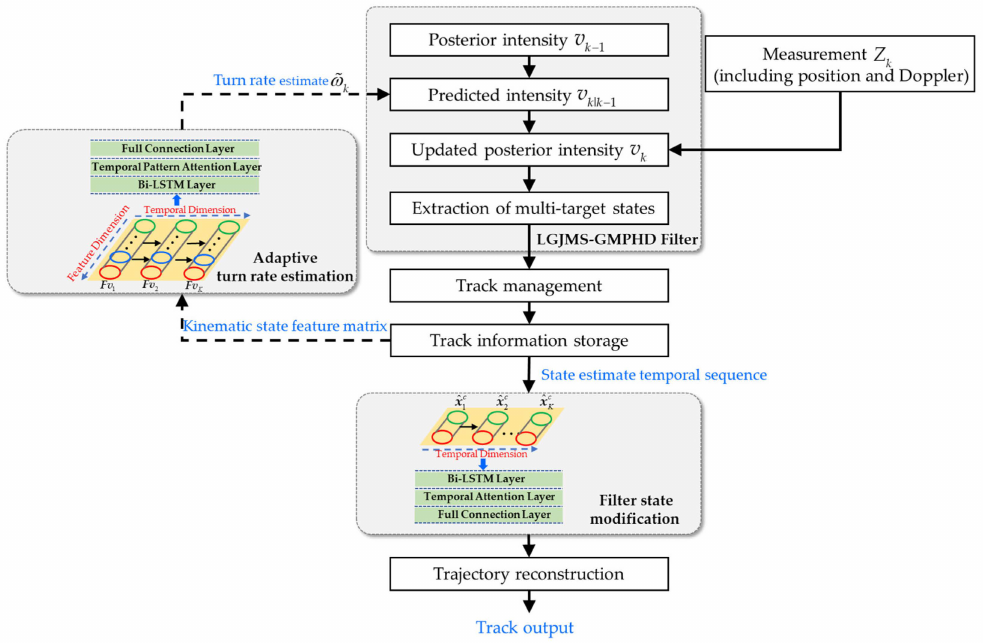
Figure 1. Flow diagram of the proposed deep-learning-based multiple model tracking